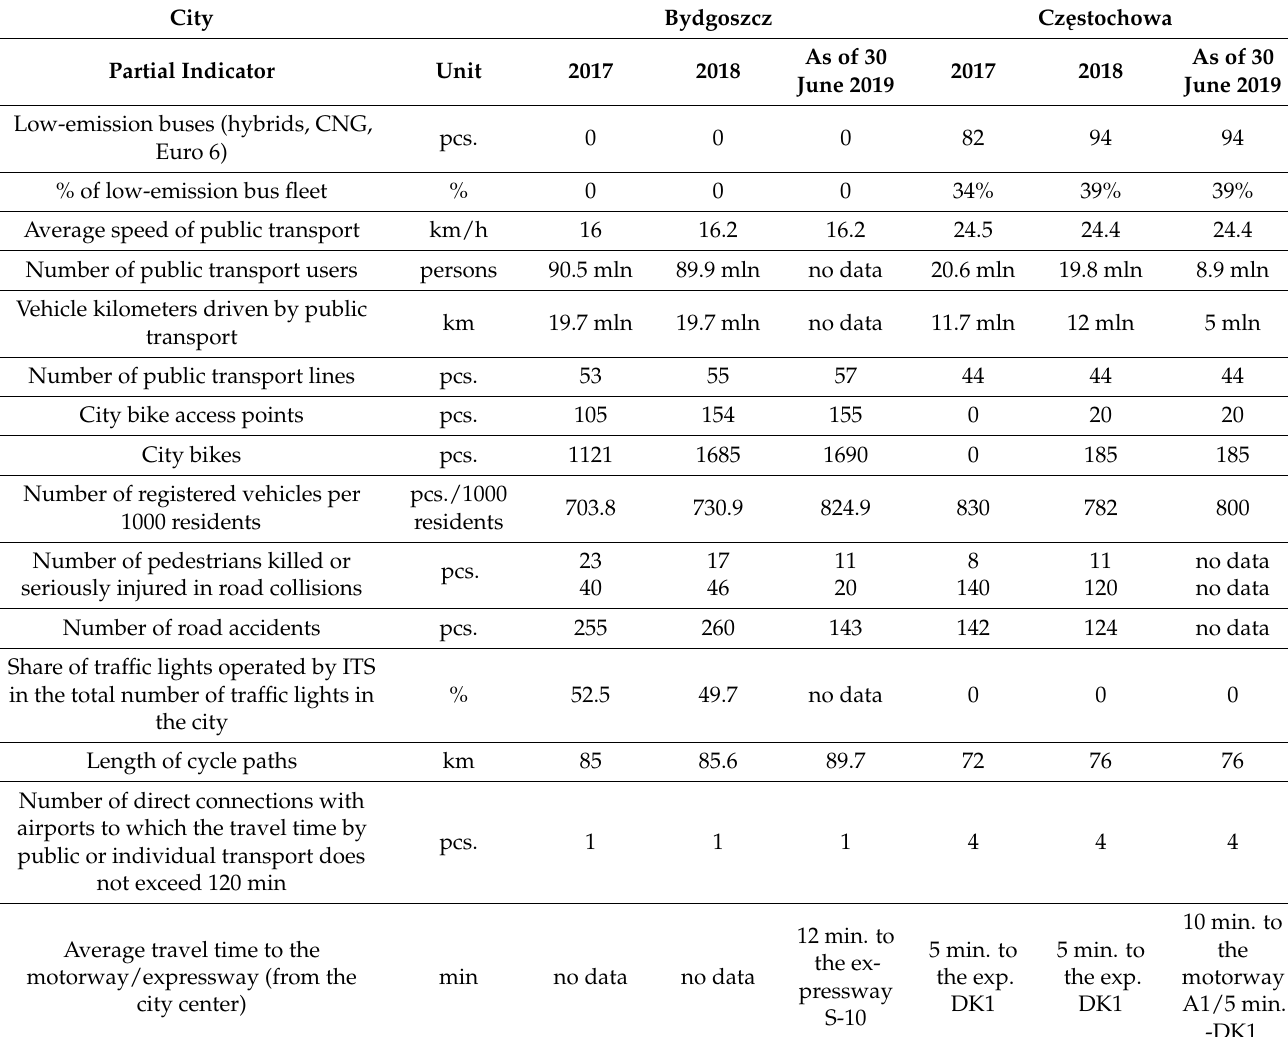
Table 6. Area 1 concerning local transport, national and international accessibility, ICT infrastructure, sustainable transport system. The measure—“local